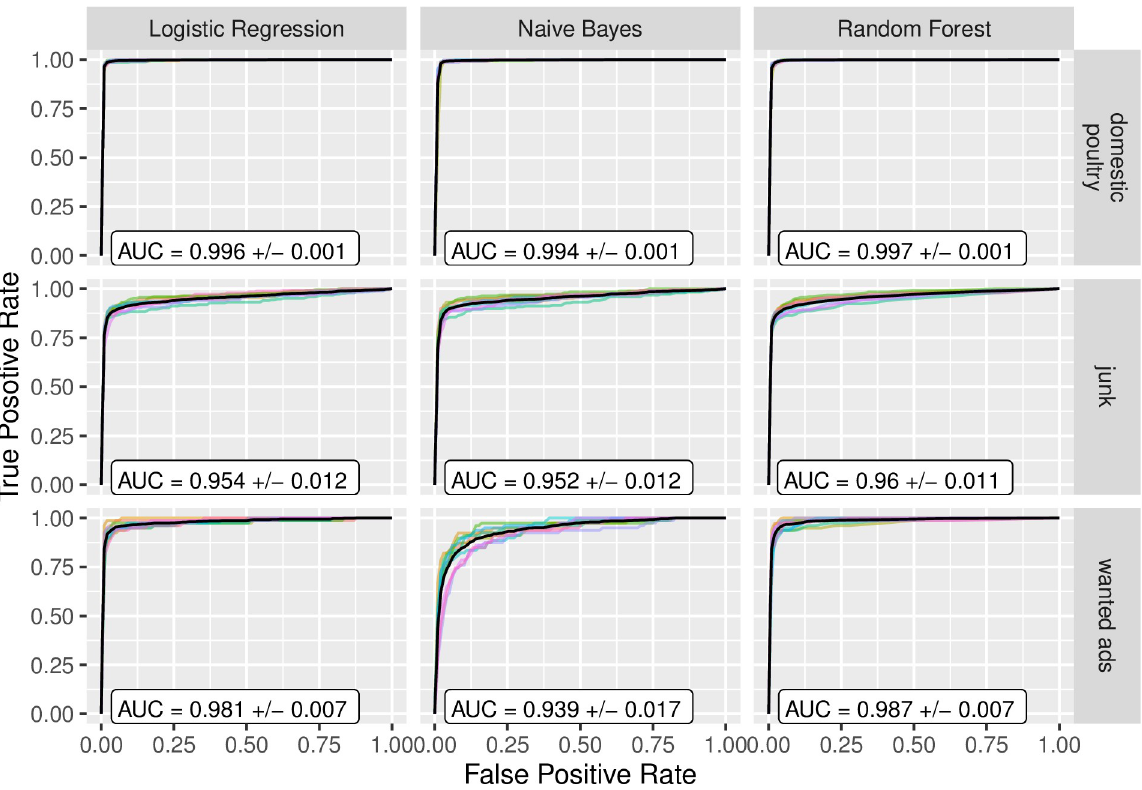
Fig 2. Receiver operating characteristic curves and the area under the curve (ROC AUC). Three different text classifiers (columns) were tested across three different labels (rows). For each panel, each line represents one cross-validation fold and the solid black line represents the average across all cross-validation folds. Average AUC (area under curve) values are reported with standard deviation.